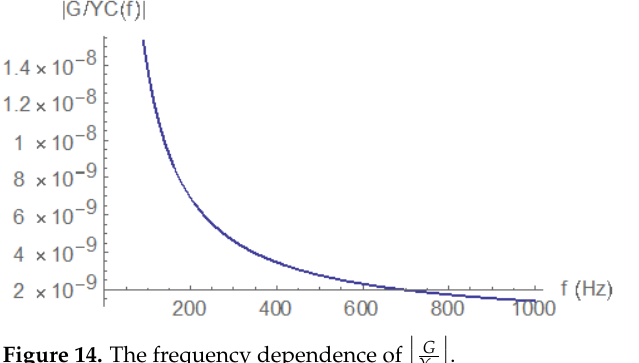
Figure 14. The frequency dependence of